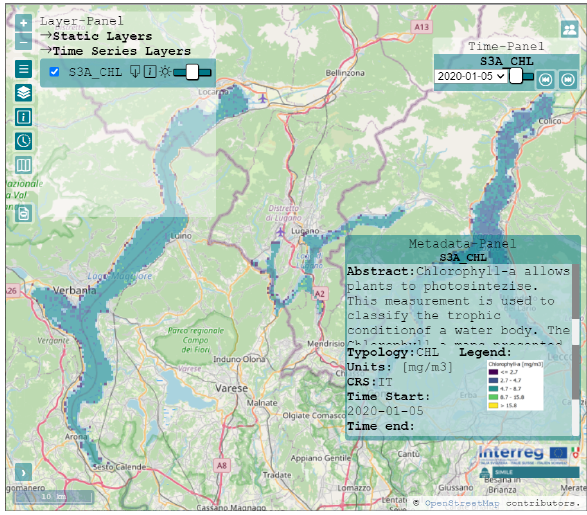
Figure 5: An example of appearance of the WebGIS (users’ ap- plication of the collaborative